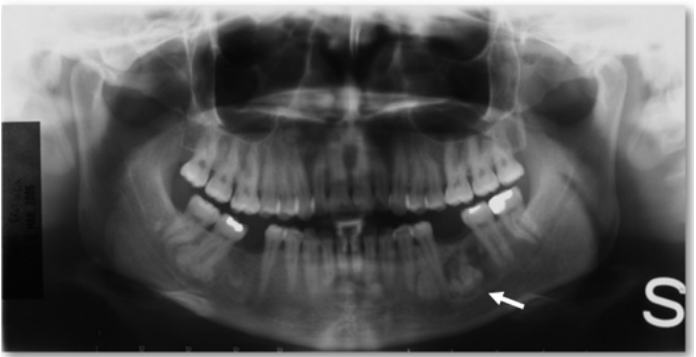
Figure 1. Central osteoma: panoramic radiograph showing a localized, well-defined radiopacity involving the alveolar bone of the left mandibular body (white arrow). The finding was incidental, and the patient did not refer to any symptoms.